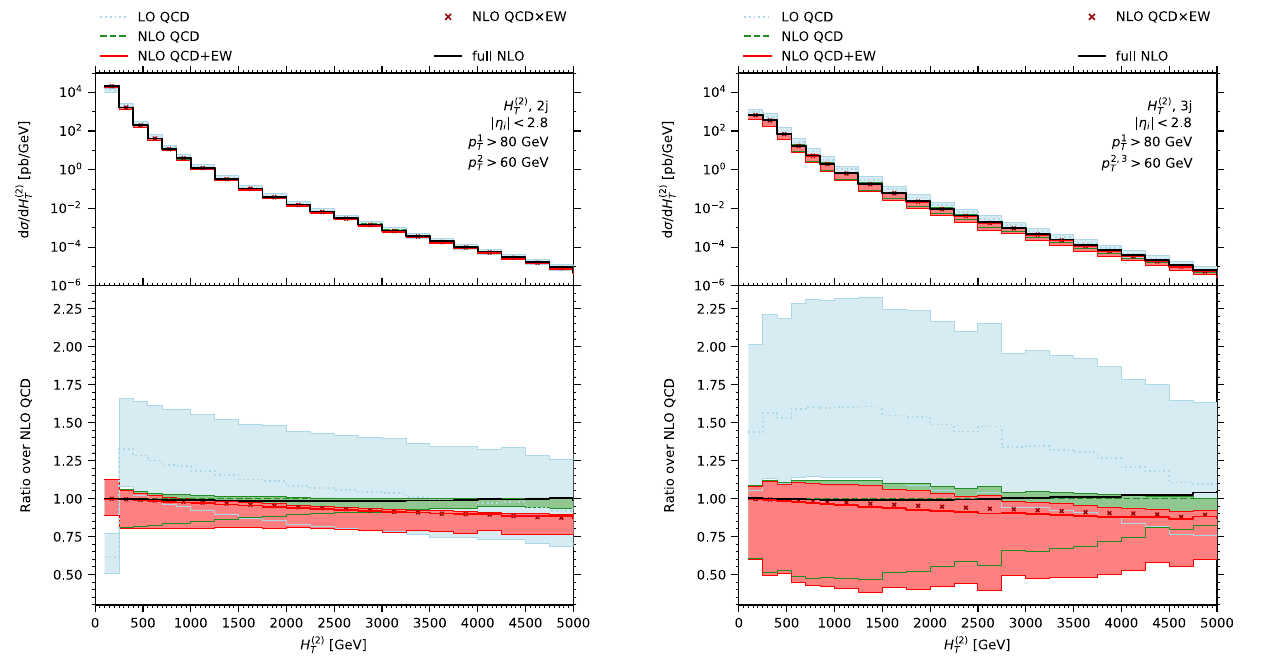
Fig. 6 The H ( 2 ) distribution in two- and three-jet production at the LHC shown in the left and right panel, respectively. Besides the full NLO T prediction the central results and scale uncertainty bands for LO and NLO QCD, NLO QCD + EW and NLO QCD + EW are shown